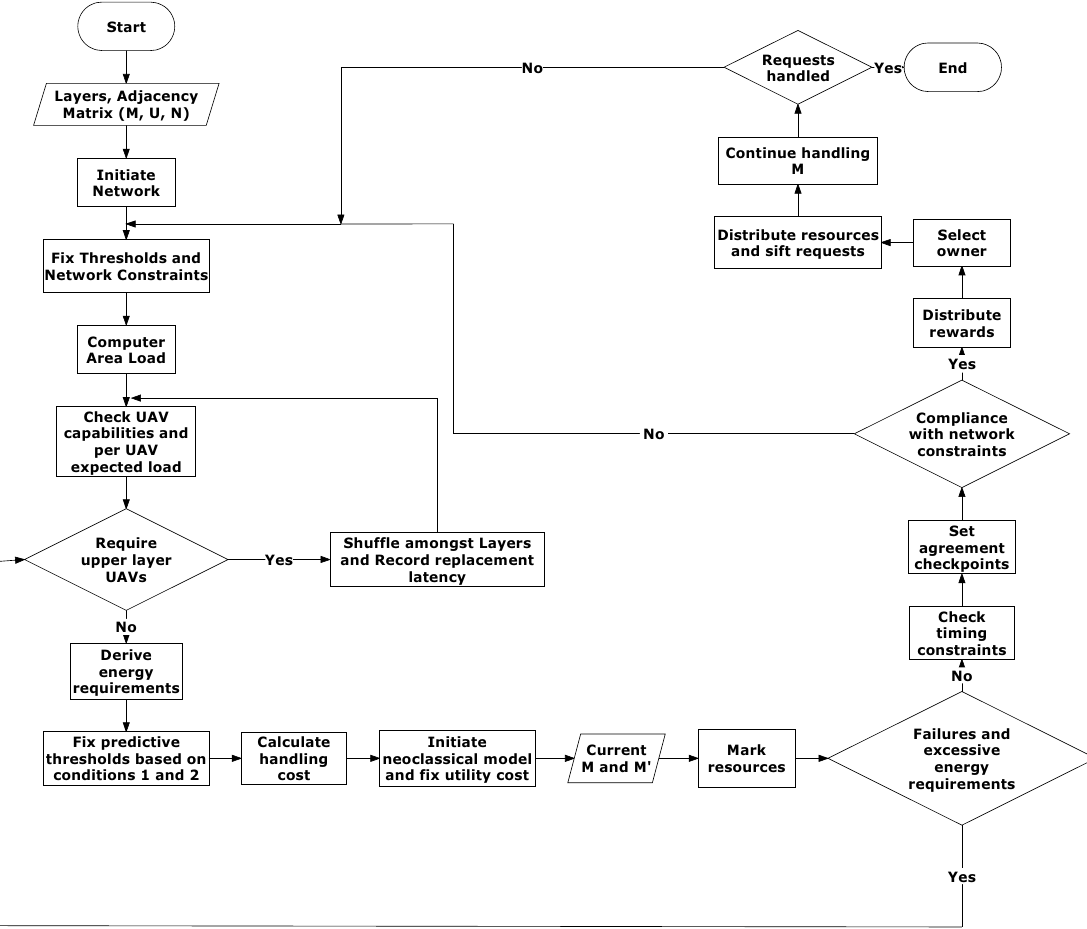
Figure 3. Flow chart representing all of the procedures and work flow for energy efficient resource allocation in